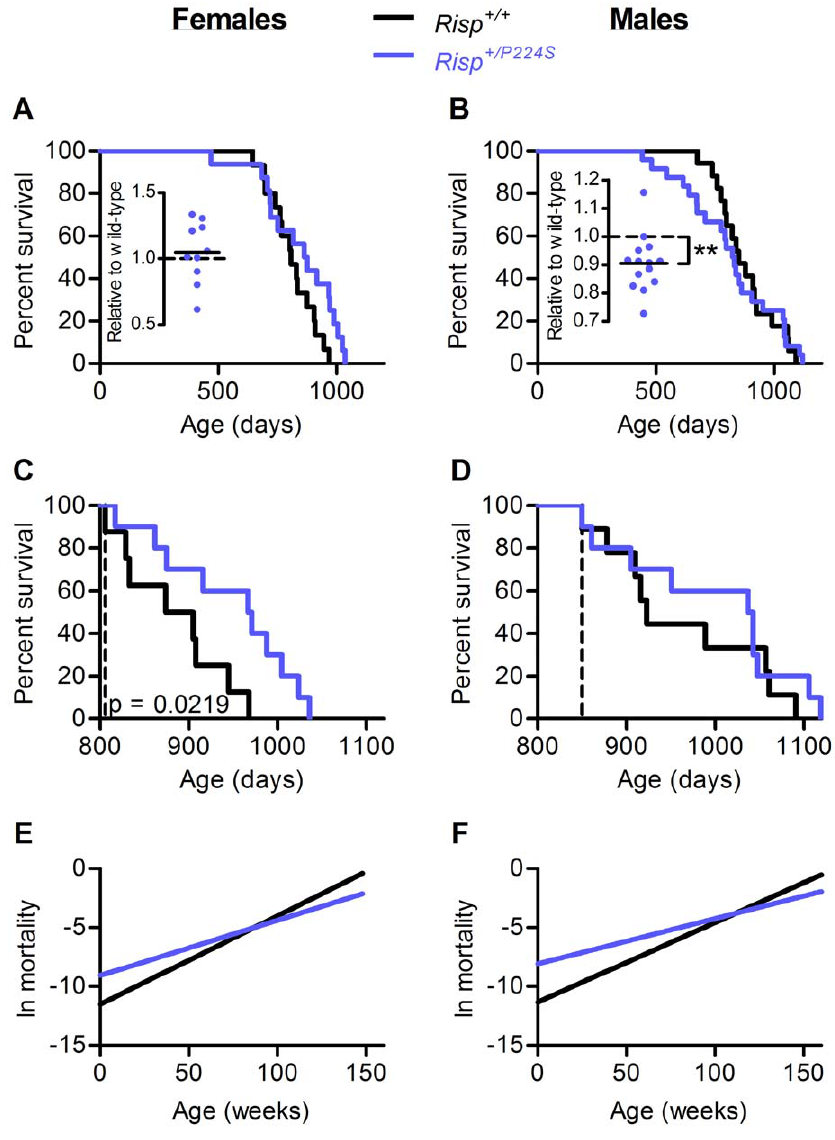
Figure 6. Lifespan and aging of Risp + / + and Risp + /P224S mice. ( A ) and ( B ) Effect of Risp heterozygosity on survival of female (15 + / + and 16 + /P224S mice) and male (17 + / + and 24 + /P224S ) mice. Insets show the relative effect of Risp heterozygosity within litters. Each point therefore represents the average lifespan of all heterozygotes within a litter divided by the average lifespan of their wild-type littermates. By this measure, Risp heterozygosity shortened lifespan by 10 percent in males (p=0.0037), with little effect in females. ( C ) and ( D ) show the remaining lifespan of Risp + / + and Risp + /P224S female and male mice that have survived to the median wild-type lifespan, indicated by the vertical dashed line (806 and 850 days for females and males, respectively). ( E ) and ( F ) Gompertz mortality curves for female and male mice. Both Gompertz parameters (the intrinsic vulnerability to death A , the y-intercept, and the age-dependent acceleration of mortality rate k , the slope) are statistically significantly different (p , 0.05).